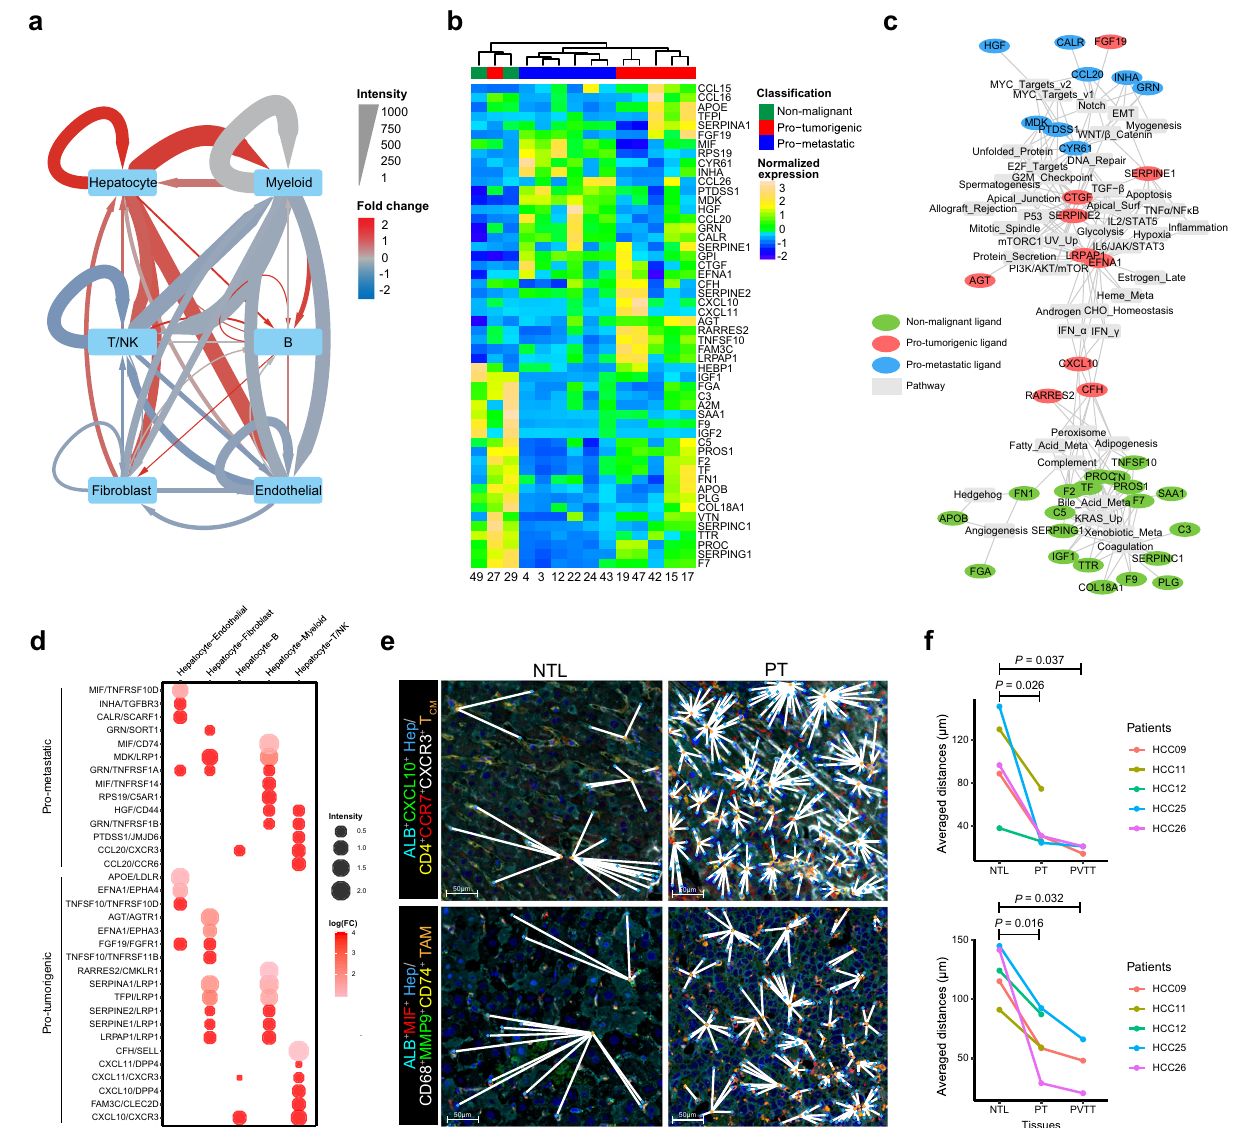
Fig.6|MalignanthepatocyteshavemultifacetedfunctionsinshapingtheHCC microenvironment.a Adirectednetworkshowingthedifferentialligand-receptor (L-R) interaction intensities among the six major cell types between the primary tumor (PT) and non-tumor liver (NTL) tissues. The averaged L-R interaction intensities in the PT and NTL tissues are represented by edge width. The fold changes of L-R interaction intensities are represented by edge color, with red denotingupregulatedandbluedenotingdown-regulatedinPTascomparedtoNTL tissues. b Heatmap showing the expression levels of all hepatocyte-expressed ligands (rows) across the malignant hepatocyte clusters (columns). Ligands and malignant hepatocyte clusters are ordered based on hierarchical clustering. c A bipartitenetworklinkingthehepatocyte-expressedligands(coloredellipses)tothe correlatedpathways(grayrectangles).Eachedgeindicatesasigni fi cantcorrelation between a ligand and a pathway ( P <0.01, Spearman ’ s ρ test). Meta metabolism, EMT epithelial-mesenchymal transition, UV ultraviolet, v1 version 1, v2 version 2. d Dotplotshowingthepro-tumorigenicandpro-metastaticL-Rinteractionsthatare